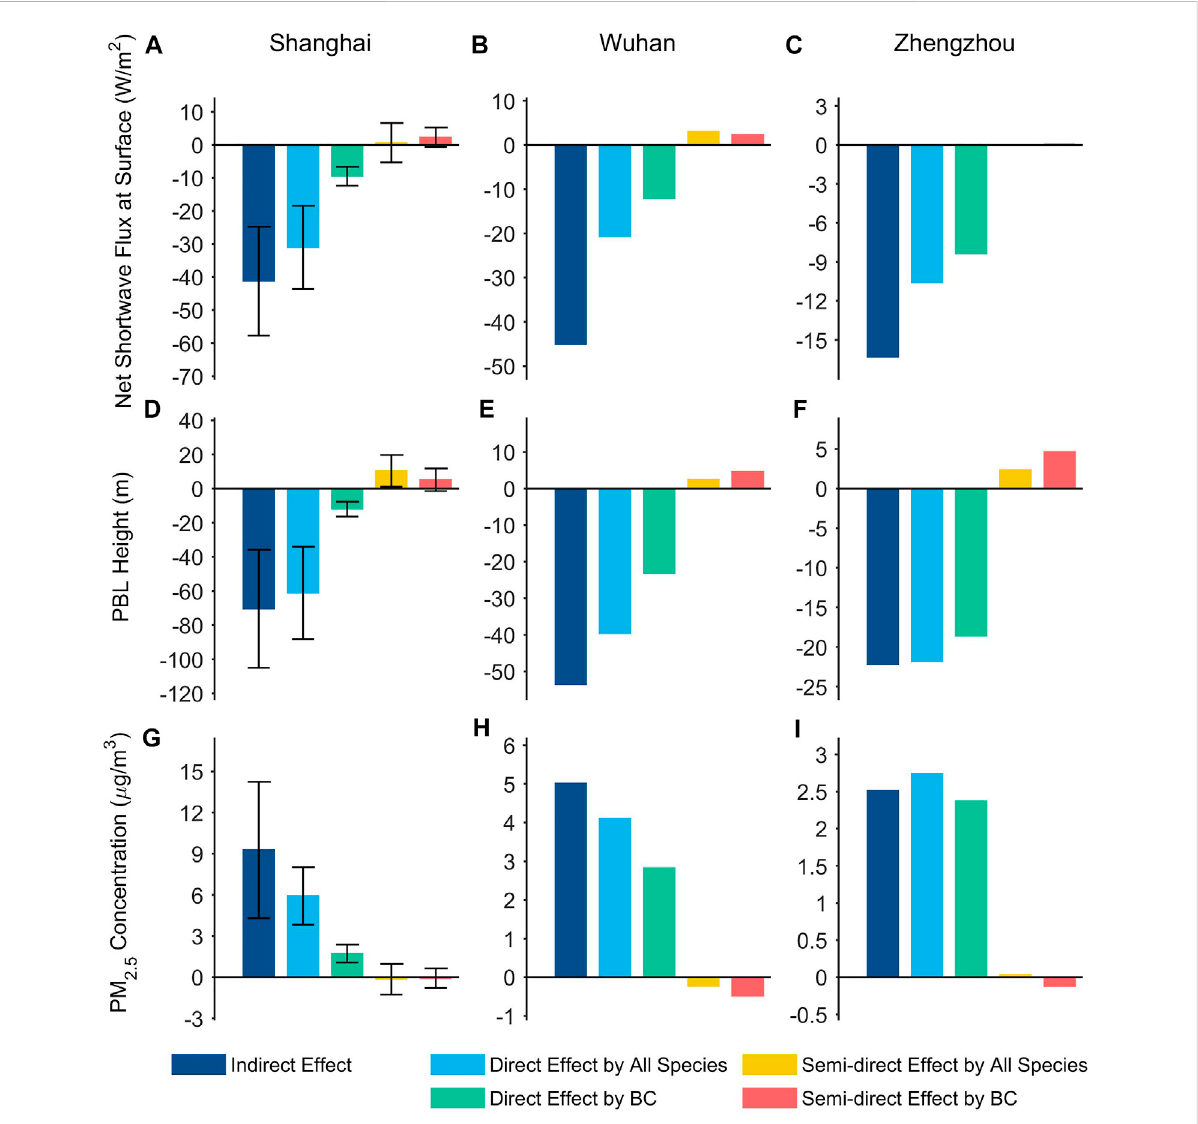
FIGURE 6 BarplotofaerosoleffectincasesofShanghai(leftcolumn),Wuhan(middlecolumn)andZhengzhou(rightcolumn). (A – C) Aerosoleffectonnet shortwave fl uxatsurface. (D – F) Aerosol effectonPBLheight. (G – I) Aerosol effectonsurfacePM2.5concentration.Allvariablesareaveragedfrom7: 00 to 17:00 LT over the box regions marked in Figure 3. For the case of Shanghai, bars and error bars represent ensemble means and standard deviations, respectively. Note that the indirect effect is scaled by a factor of 0.5 in this fi